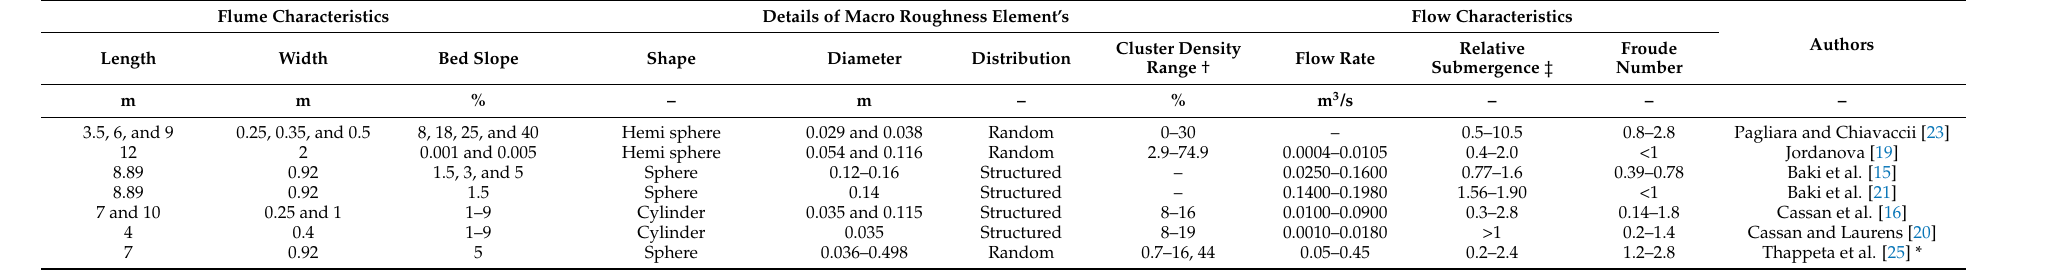
Table 1. Experimental investigation on head loss due to macro roughness